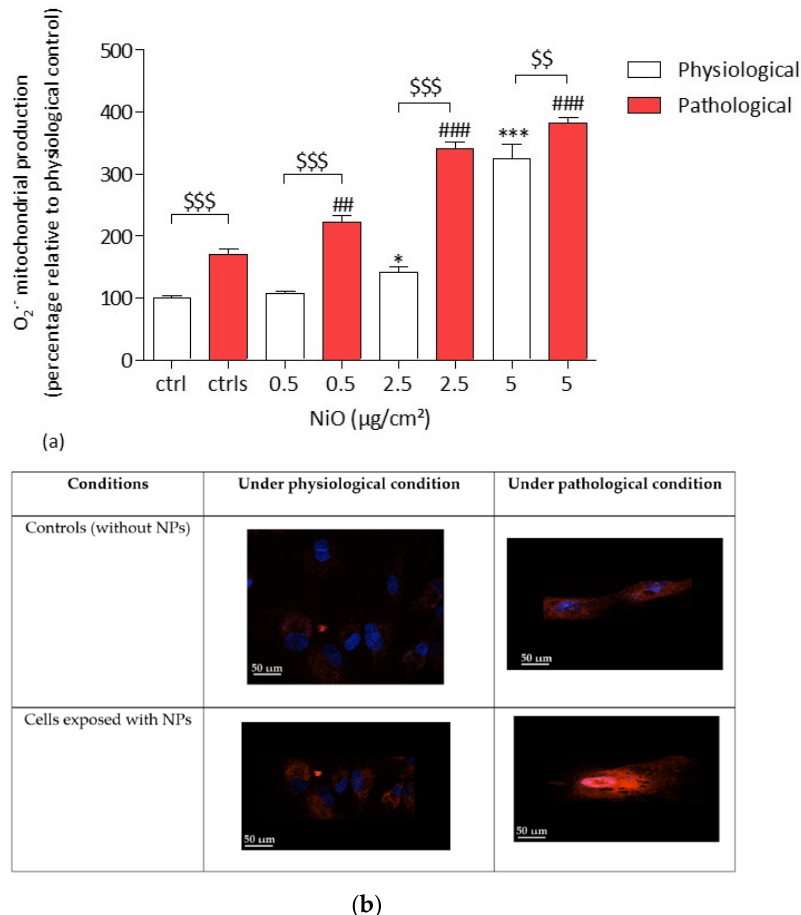
Figure 3. Mitochondrial O 2 − production in HPAEC after a 4 h exposure to NiONPs (0.5–5 μ g/cm 2 ) under physiological and pathological conditions, measured by confocal microscopy. ( a ) The values were normalized to the untreated physiological cells and results were expressed as the percentage of the MitoSox probe fluorescence intensity relative to the control cells. ( b ) HPAEC observed by confocal microscopy at focus 60×, under physiological and pathological conditions, without or with NiONPs (2.5 μ g/cm²), with mitochondria marked in red, with MitoSox probe and nucleus in blue, with Hoechst probe. Data were mean ± SEM of three independent experiments ( n = 3) performed in quadruplicate. * p < 0.05 and *** p < 0.001 vs. untreated cells in 0% CS in normoxic conditions. ## p < 0.01 and ### p < 0.001 vs. untreated cells in pathological conditions. $$ p < 0.01 and $$$ p < 0.001 between both conditions. According to one-way ANOVA followed by Tukey’s post hoc test for mul- tiple comparisons.